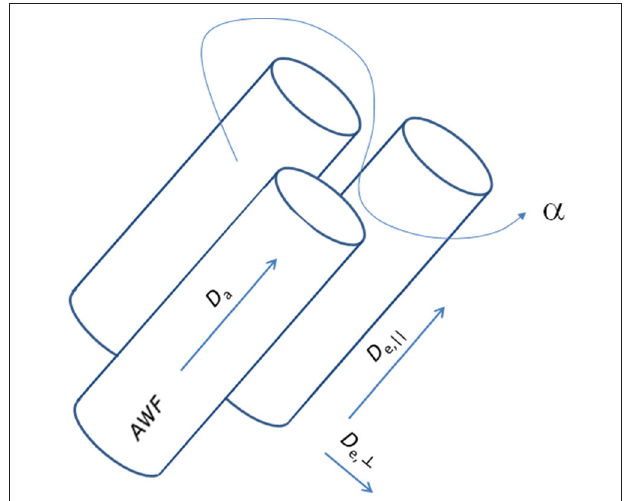
FIGURE 2 | Schematic representation of a white matter fiber bundle and its biophysical properties accessible with the WMTI analysis